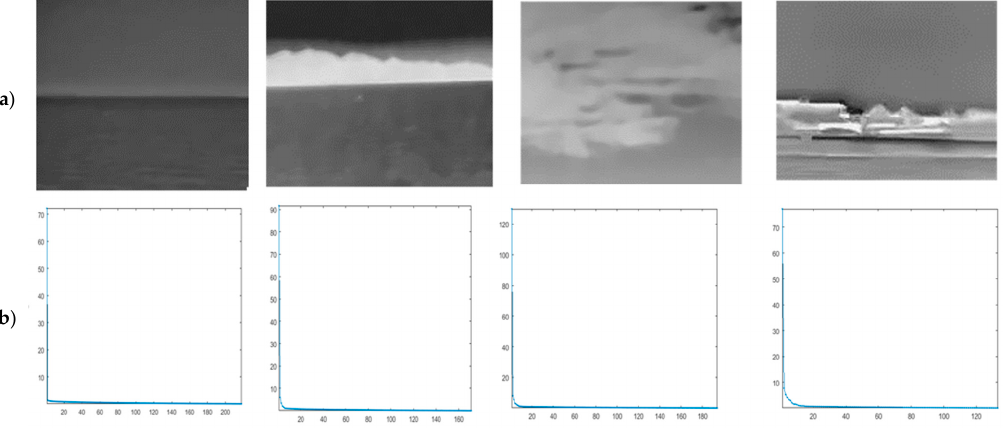
Figure 1. Characteristics of the background patch images with a low rank: ( a ) four different representa- tional background images and ( b ) singular value distribution of corresponding background images.